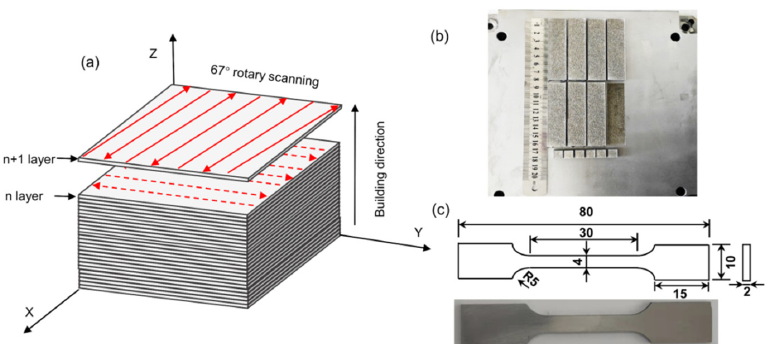
Figure 2. ( a ) Schematic diagram showing laser scanning approach during additive manufacturing; ( b ) Produced samples of cuboid and cubes; ( c ) Sample size for tensile test.